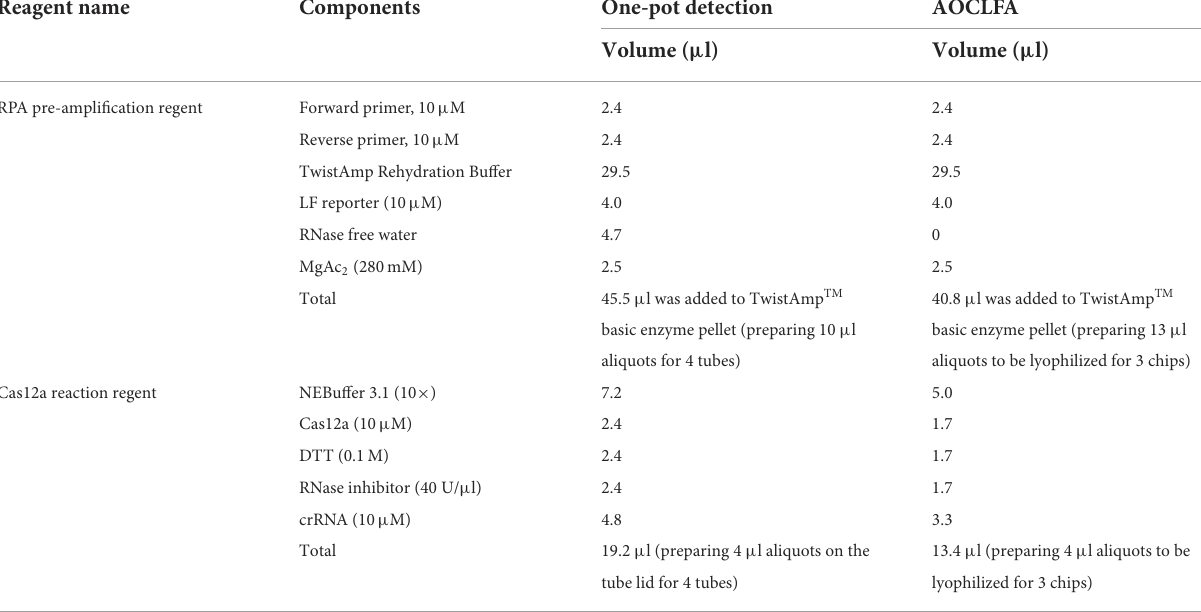
TABLE 1 One-pot detection and all-in-one chip